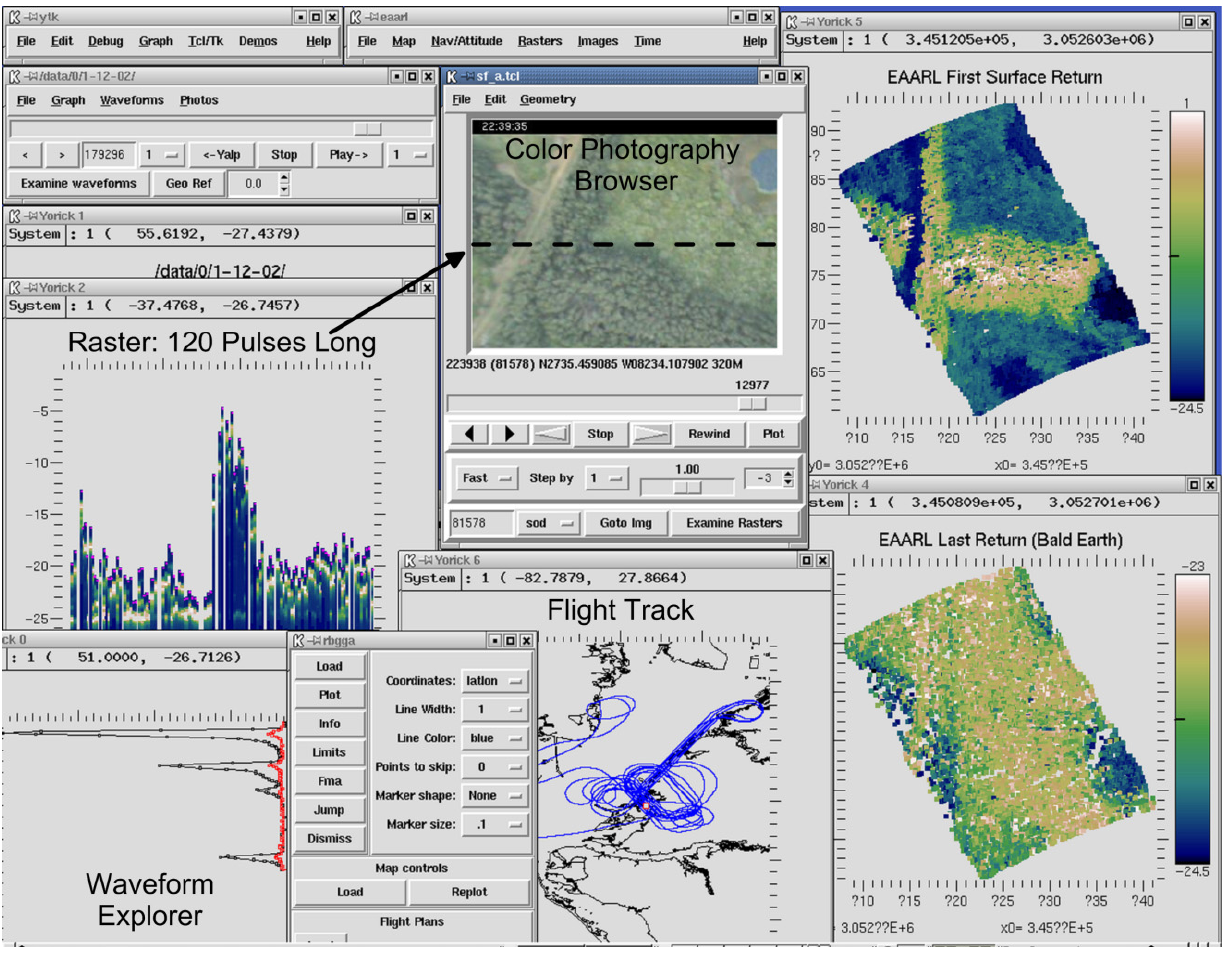
Figure 4. Airborne LIDAR Processing Software (ALPS) user interface. All inset windows display information from the position of the red dot in the lower middle of the flight track